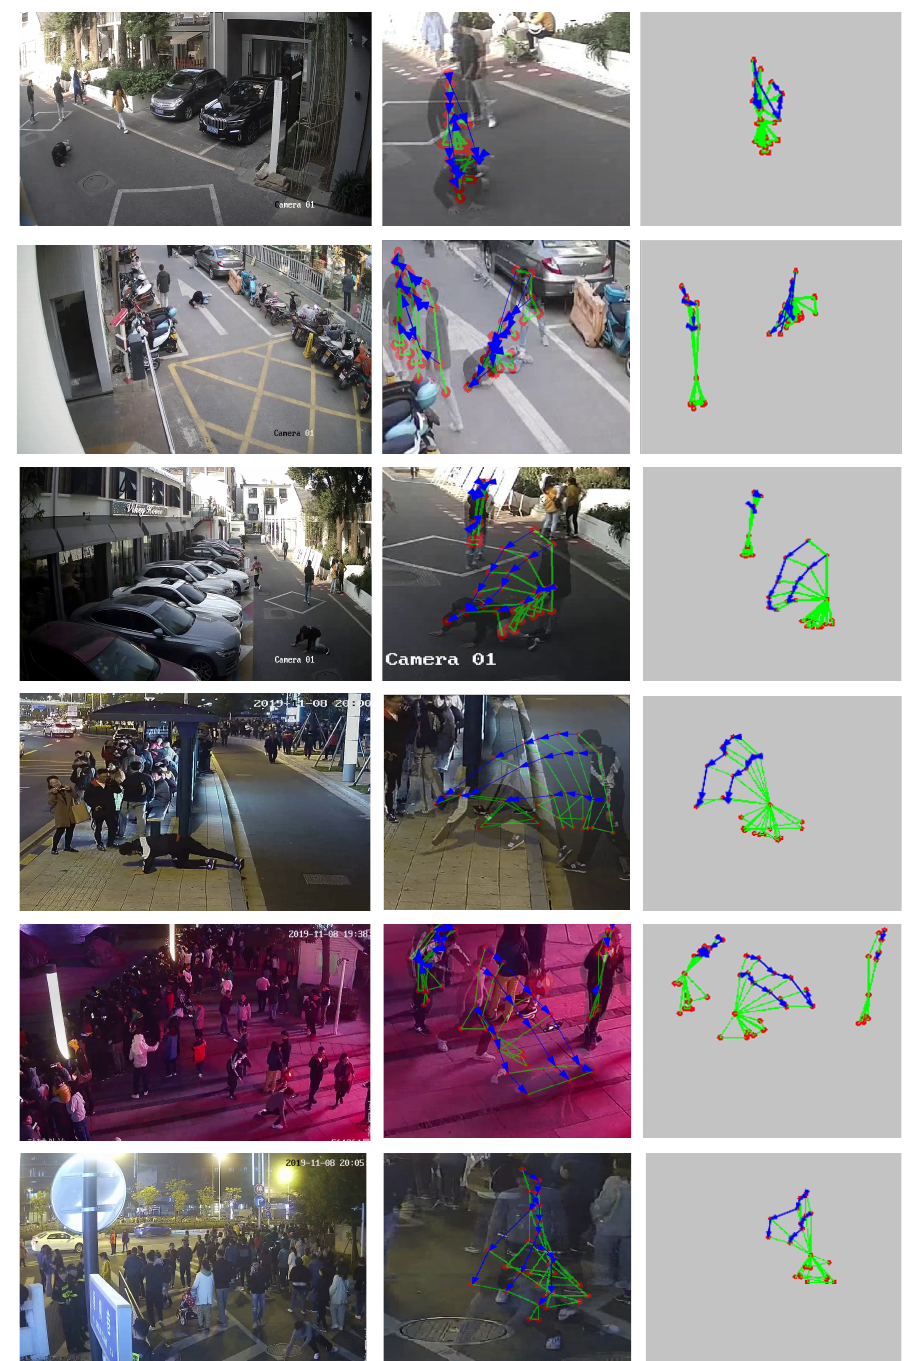
Figure 7. The extraction results of standard spatio-temporal evolution map in (5–10) scenarios. The left are input images from each the scenario; the middle are spatio-temporal evolution maps which describe the human body motion at the time sequence; the right are the standard spatio-temporal evolution maps (if the rotational energy is less than the threshold value, the standard spatio-temporal evolution map does not display for improving the efficiency of